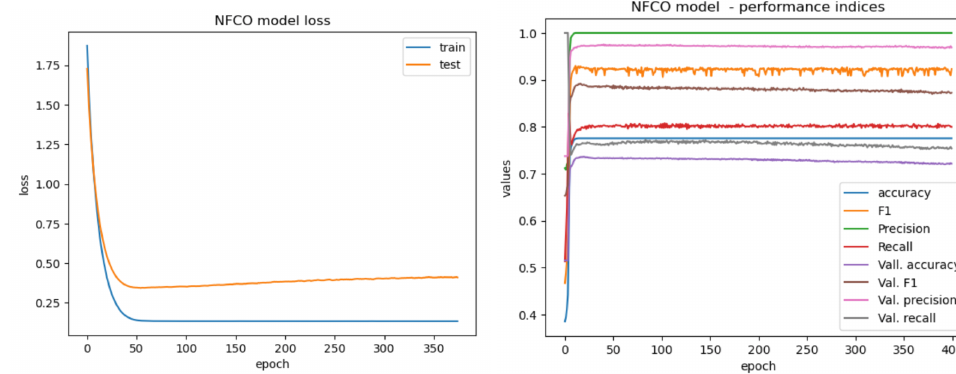
Figure 6. Convergence of the NCFO performance metrics. Table 3. Soft accuracy for different configurations of the parameters. Dataset without ontology